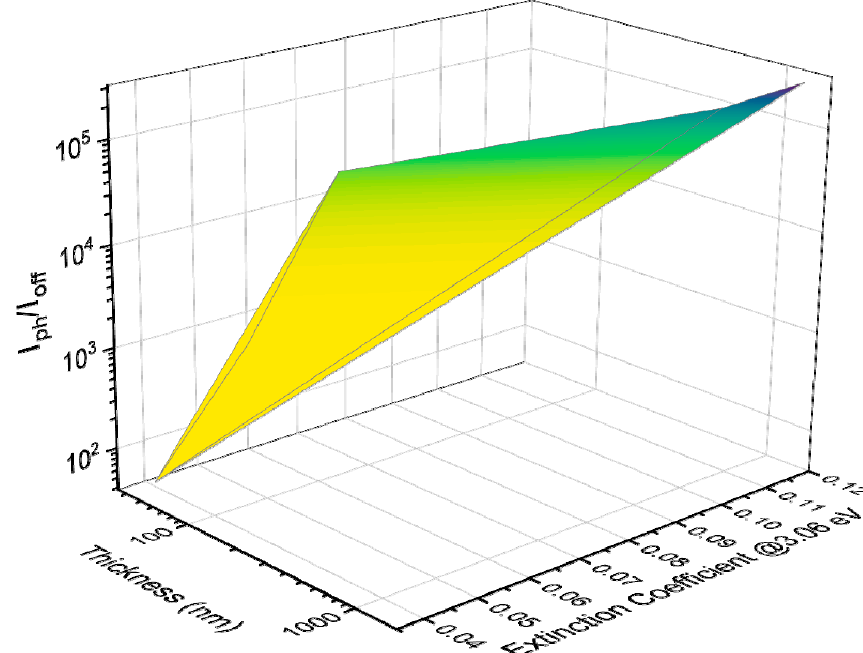
Figure 5. Photo-to-dark current ratio I ph /I off under UV-light (405 nm) irradiation as a function of the thickness and of the extinction coefficient at 3.06 eV.